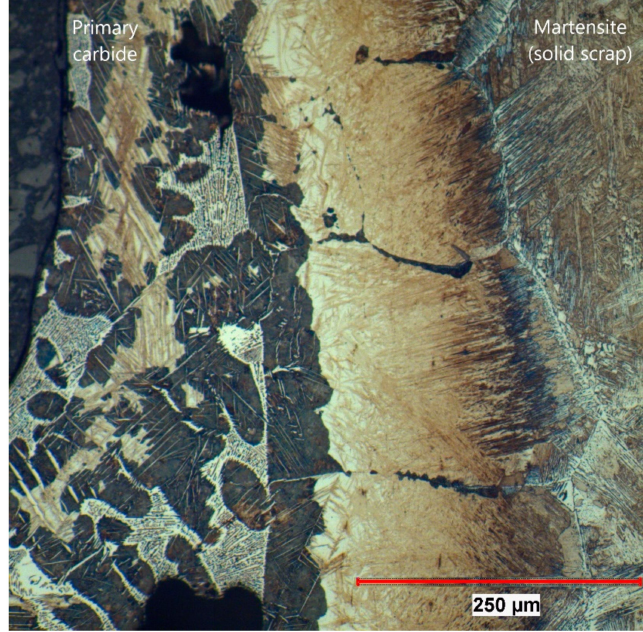
Figure 9. Section where the EPMA measurement was carried out for sample 59 (60 s immersion time at 1385 ◦ C equilibrium